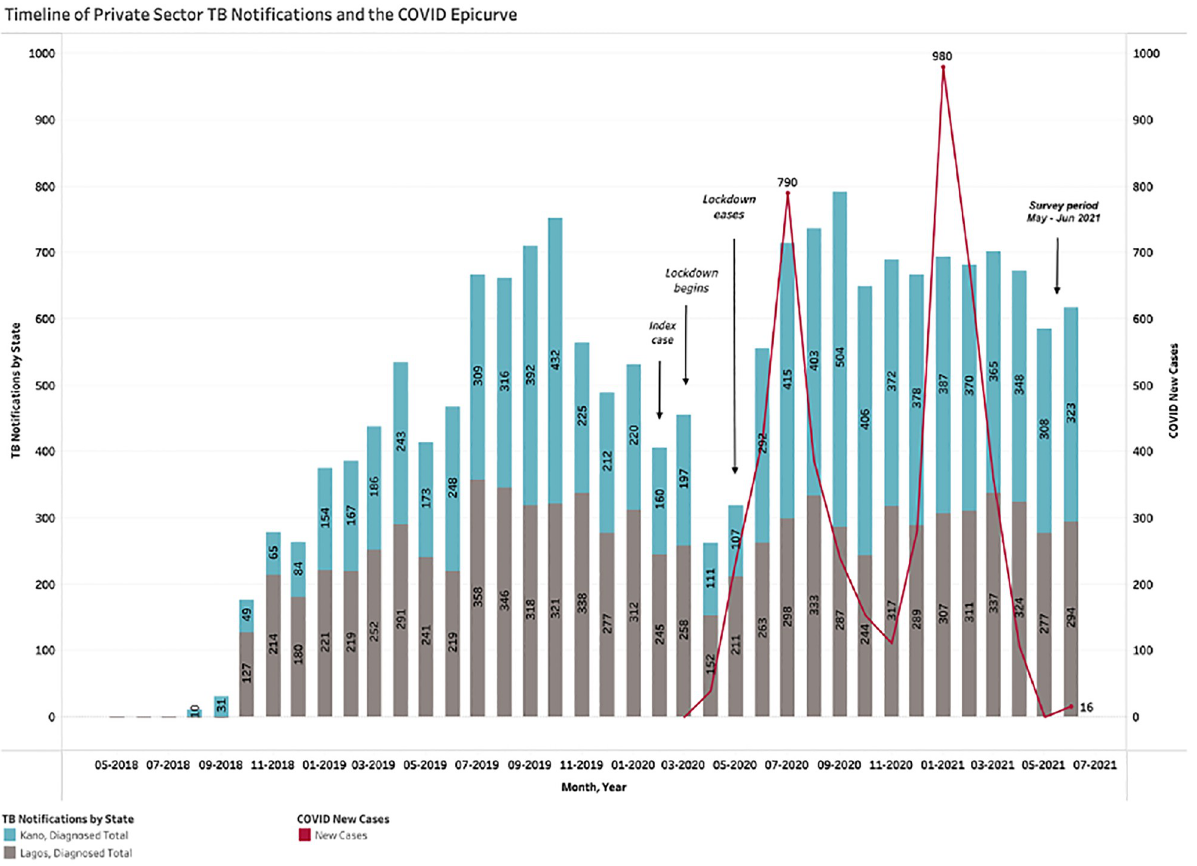
Fig 3. COVID epi curve and TB notifications in Kano and Lagos from January 2019 to July 2021.